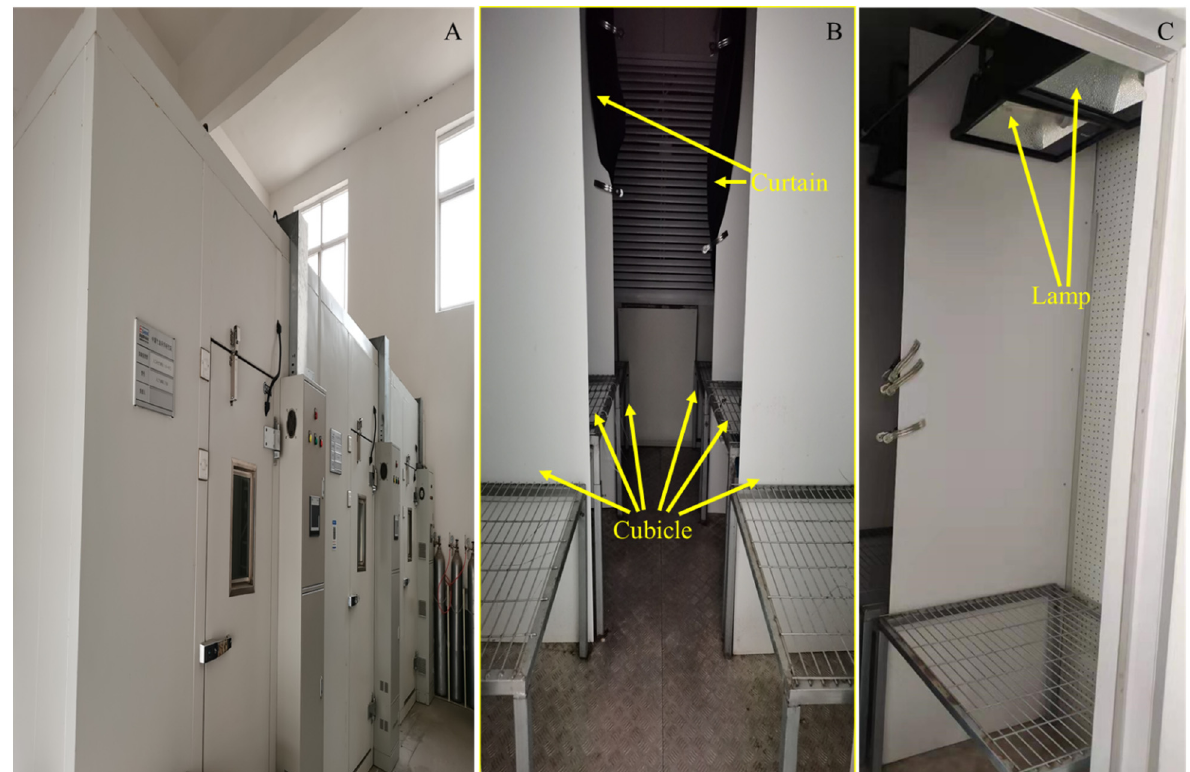
Figure 1. The large artificial climate chamber photos showing ( A ) the three artificial climate chambers, ( B ) six cubicles of each chamber separated by wooden boards and opaque curtains, and ( C ) a view of the cubicle and the lamps in it.